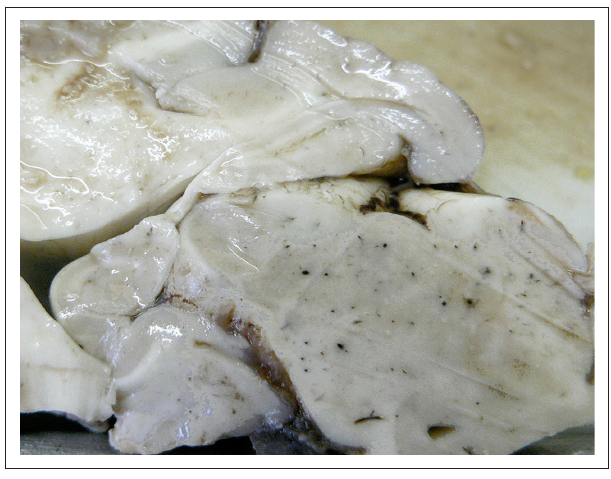
FIGURE 2: Thalamus of lineage 2 West Nile virus positive Arabian stallion Case 4 showing macroscopic vascular distension and